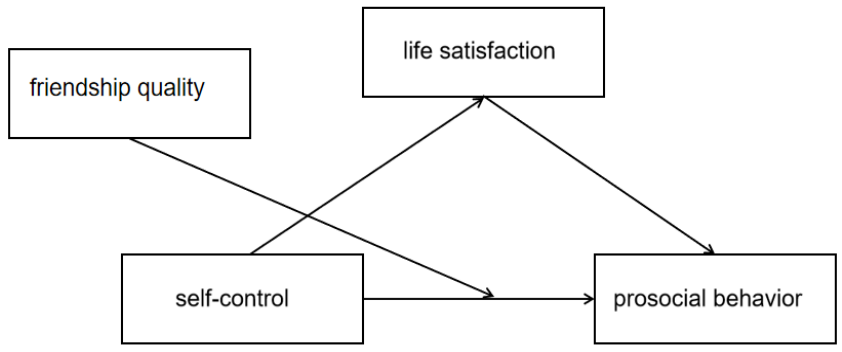
Figure 1. The proposed theoretical model.